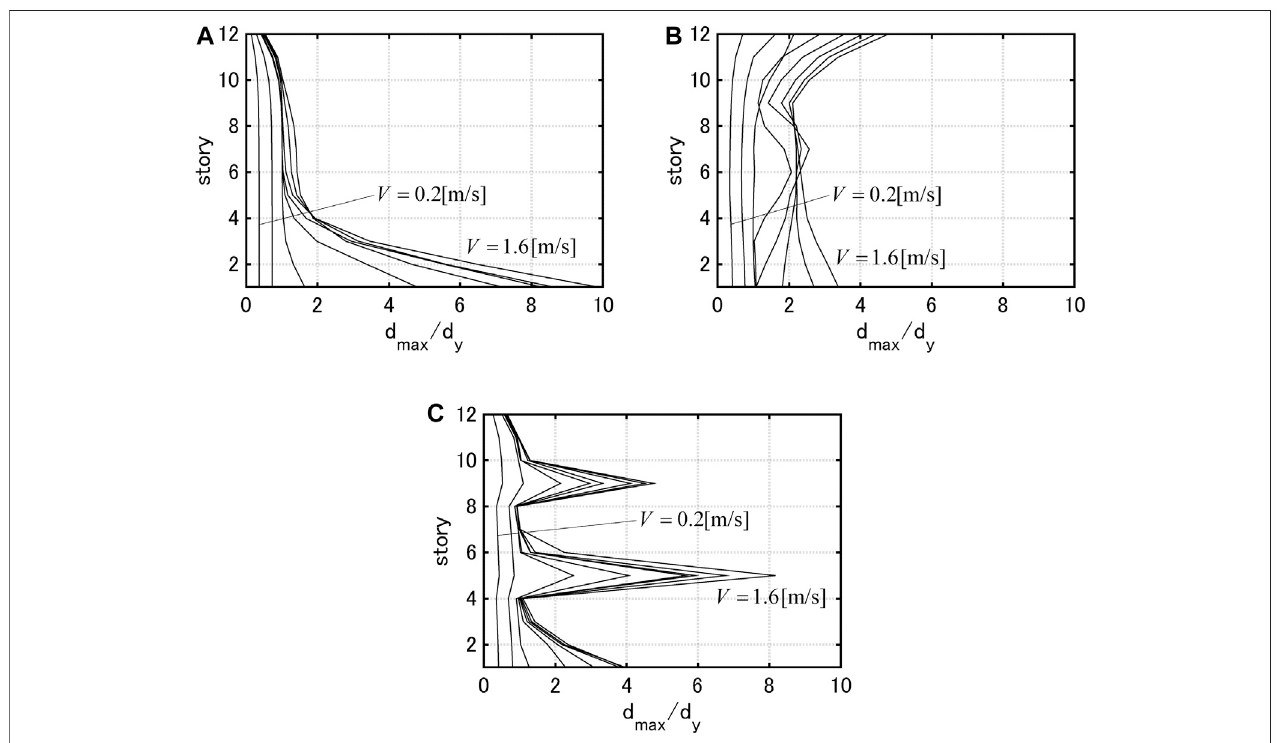
FIGURE 4 | Maximum interstory drift by the DIP analysis: (A) Model 1, (B) Model 2, (C) Model 3 (Akehashi and Takewaki, 2019).